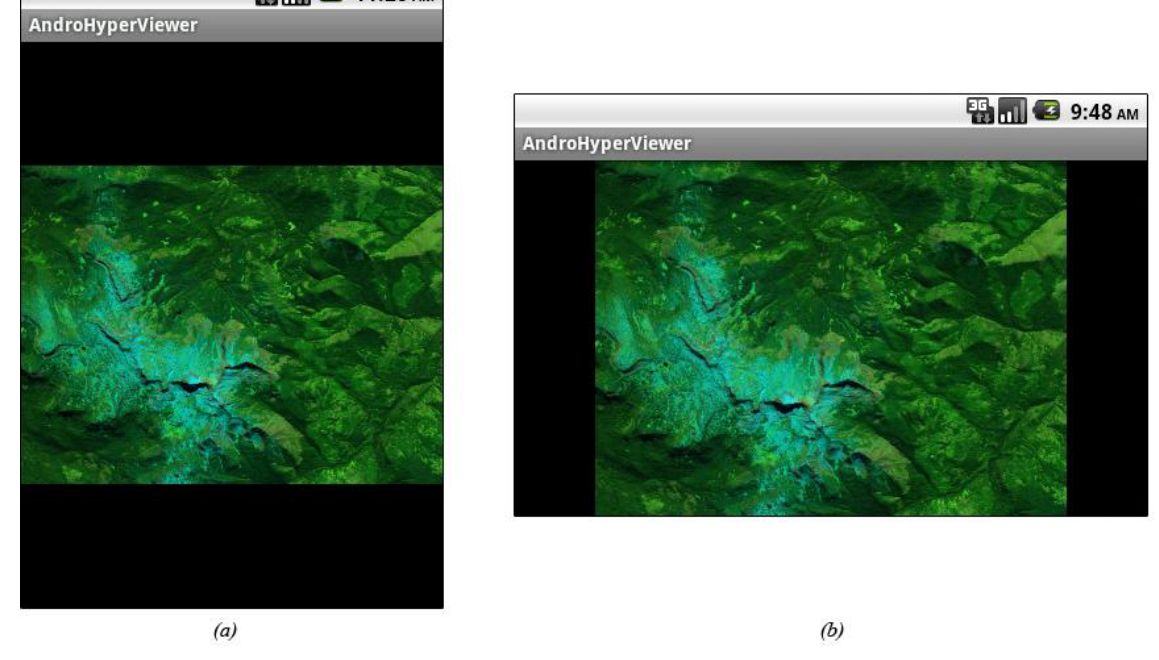
Figure 6. Yellowstone Calibrated Scene 18 on Google Android SDK Emulator in portrait mode and landscape mode with a HVGA screen